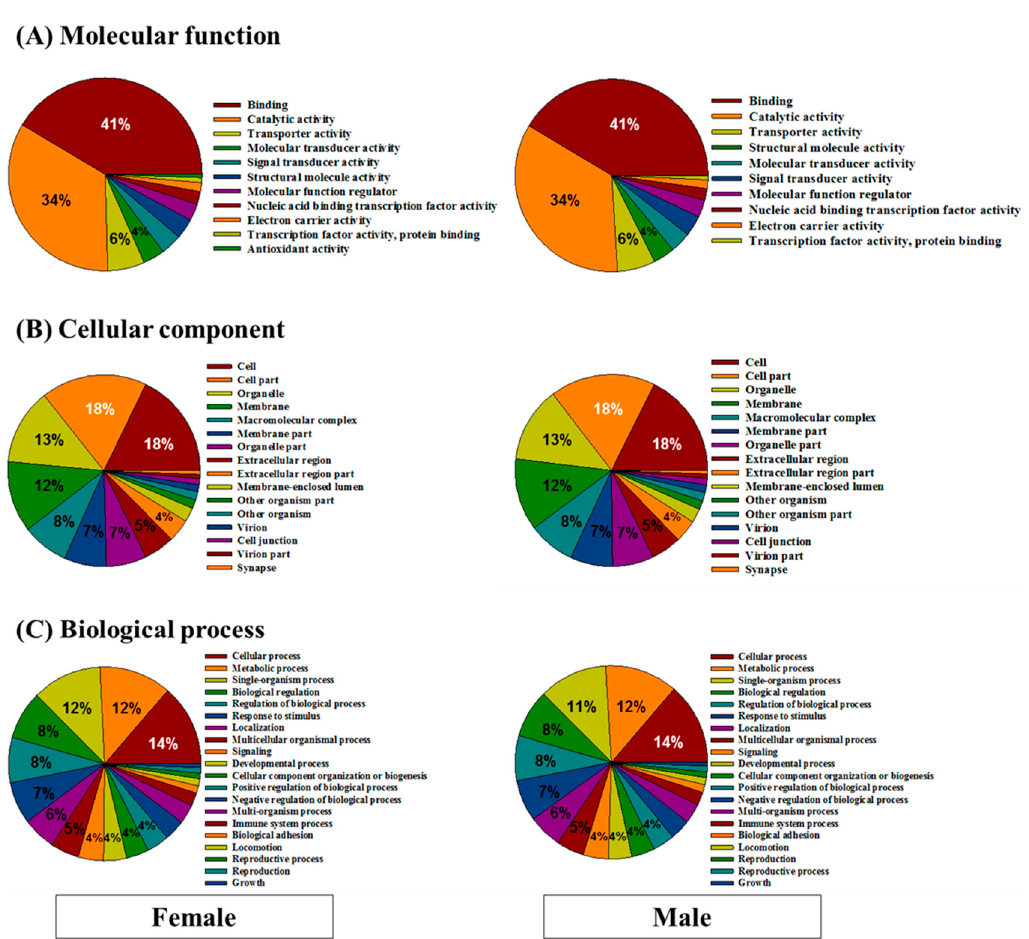
Figure 4. Gene Ontology (GO) analysis in terms of ( A ) molecular function, ( B ) cellular component, and ( C ) biological process that are enriched in the female and male Haliotis discus hannai transcript contigs.